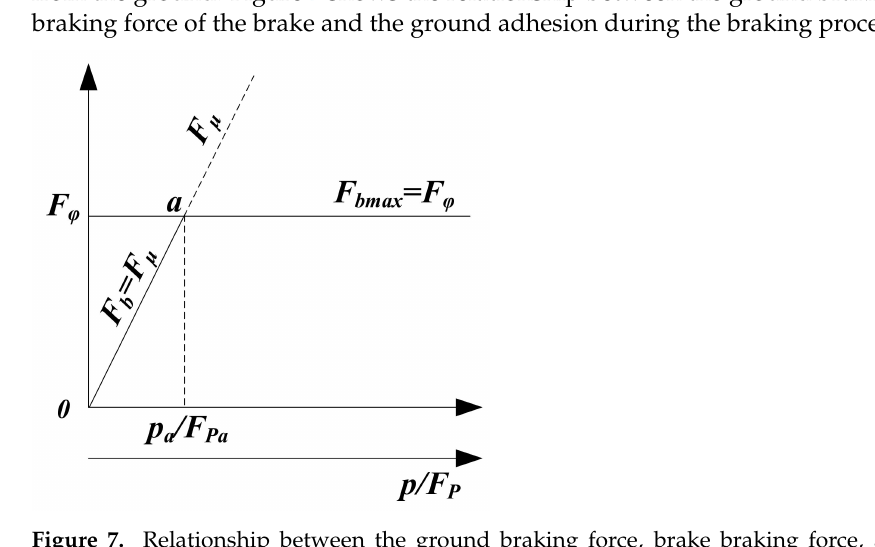
Figure 7. Relationship between the ground braking force, brake braking force, and adhesion during